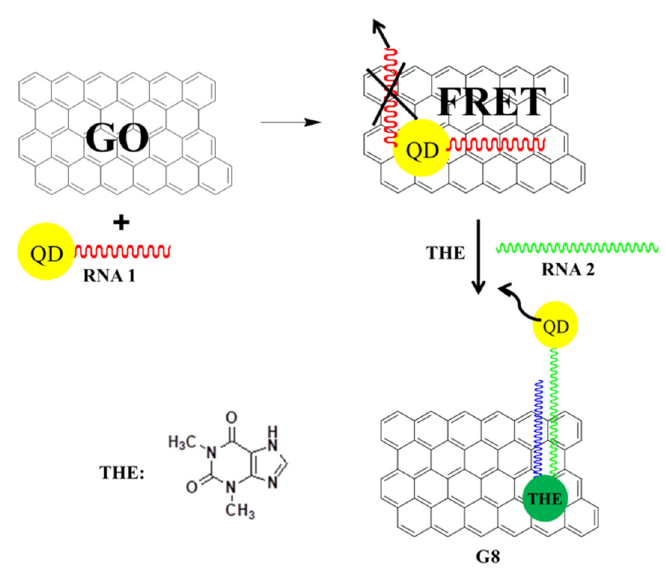
Figure 10. Schematic illustration of the fabrication of GO-ssRNA QDs ( G8 ) and their sensing mechanism. Reprinted from [64] with the permission from the Royal Society of Chemistry.